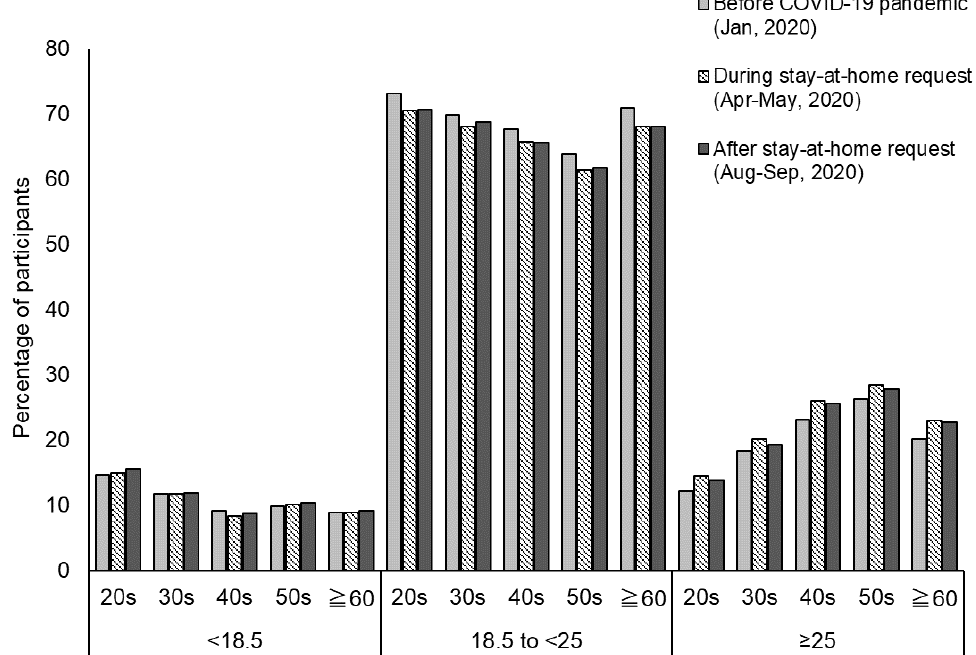
Figure 1. Distribution of body mass index before the COVID-19 pandemic, during the stay-at-home request period, and after the stay-at-home request period among participants with extended at-home hours during the stay-at-home request period ( n = 3272).